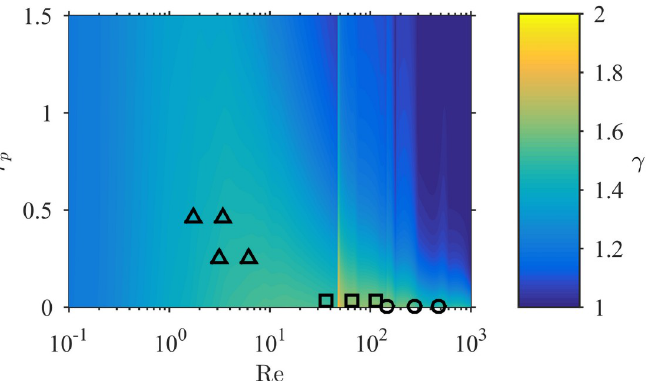
γ ), over the entire 1